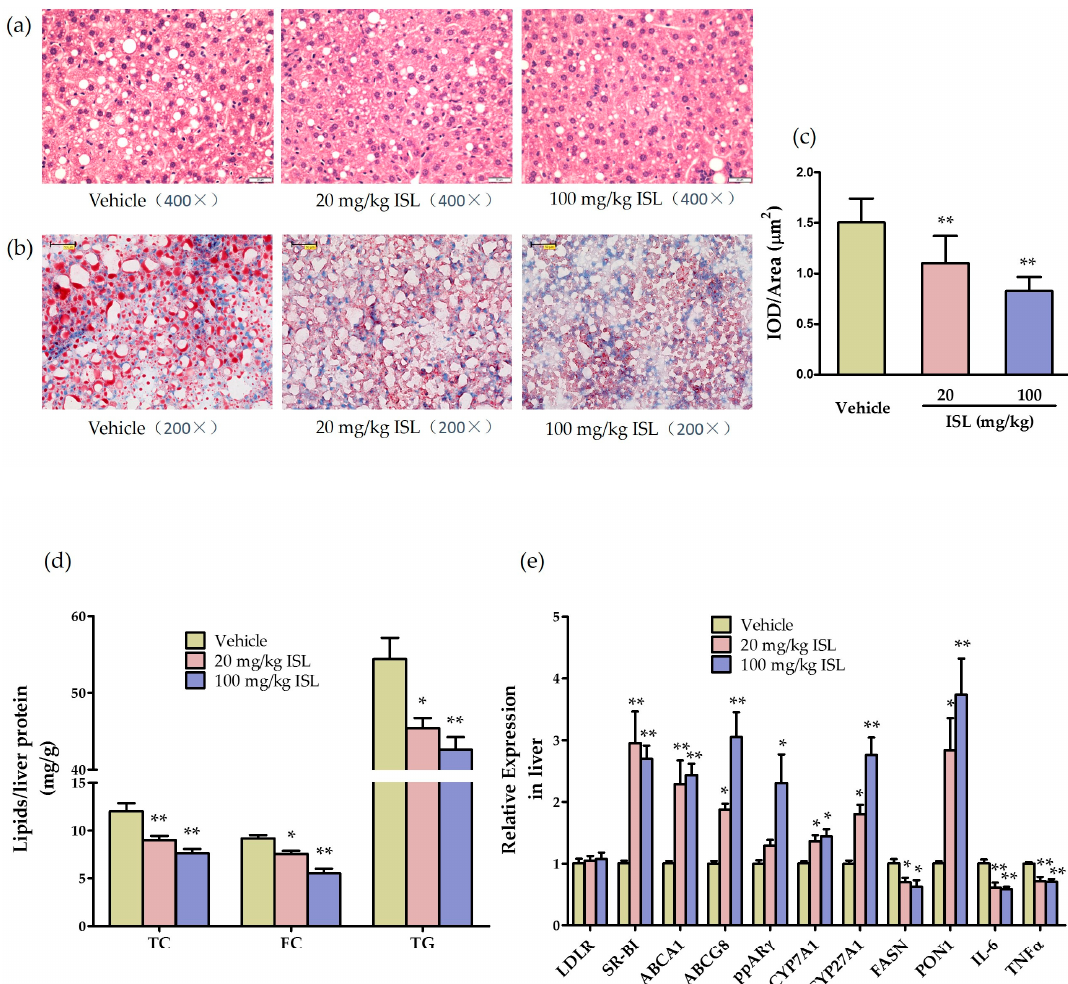
Figure 5. ISL attenuates hepatic steatosis by altering the expression of lipoprotein-metabolism-related genes. ( a ) Histochemical analysis of paraformaldehyde-fixed liver tissue was performed using hematoxylin and eosin (HE) staining (5 µ m serial sections, 400 × ); ( b ) histochemical analysis of fresh liver tissue was performed by oil red O staining (5 µ m serial sections, 200 × ); ( c ) quantitative analysis of the lipid content in liver; ( d ) the amounts of total cholesterol (TC), free cholesterol (FC), and triglyceride (TG) were determined using isopropanol, as described in Methods, and expressed as milligrams per gram of liver protein ( n = 4–5; * p < 0.05, ** p < 0.01 vs. vehicle group); ( e ) mRNA expression of LDL receptor ( LDLR ), scavenger receptor class B type I ( SR-BI ), ABCA1 , ATP-binding cassette subfamily G member 8 ( ABCG8 ), PPAR γ , cholesterol 7- α hydroxylase ( CYP7A1 ), cholesterol 27- α hydroxylase ( CYP27A1 ), fatty acid synthase ( FASN ), PON1 , IL-6 , and TNF- α in livers of apoE − / − mice was measured using qPCR with the expression level of each gene normalized to the level of 18S RNA ( n = 4–5; * p < 0.05, ** p < 0.01 vs. vehicle group).